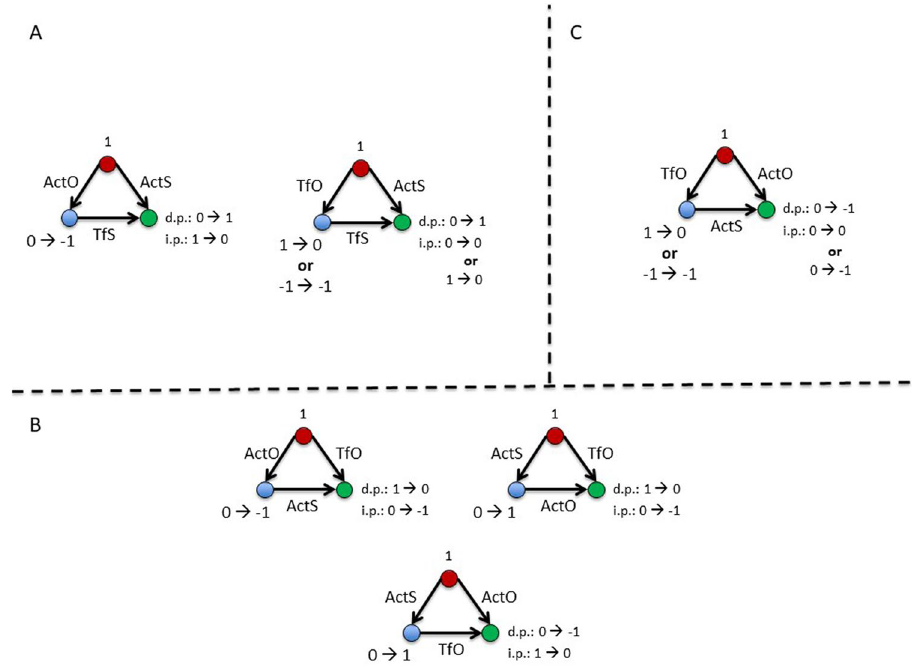
Figure 13. Dynamic of 2 nd order subgraphs. Source, middle and sink nodes are in red, blue and green colour, respectively. (A) On the sink node the ActS rule applies on the direct pathway, and the TfS on the indirect pathway. The middle node is modulated by an opposite rule: ActO and TfO for the ActO/TfS/ActS and the TfO/TfS/ActS triads, respectively. (B) the ActS/TfO/ActS and Acts/ActO/TfO, are symmetrical Flux triads in which the same mechanism operates: indirect pathway (de-)activates the sink node in the opposite state than the source, while the direct pathway turn off the sink node if in the same state of the source. The same occurs, although with inverted pathways, for the Flux ActS/TfO/ActO, in which the indirect way turns off the sink node if in the same state of the source, while the direct way changes its state to the opposite than the source. (C) The Flux TfO/ActS/ActO operates as a competition solving mechanism: since the sink node is subjected to the competing rules ActS and ActO, the source to middle pathway solves the impasse turning off the ActS rule and promoting the opposite state. It is worth to note that also in this case the symmetrical form promoting the ActS rules is not significant.